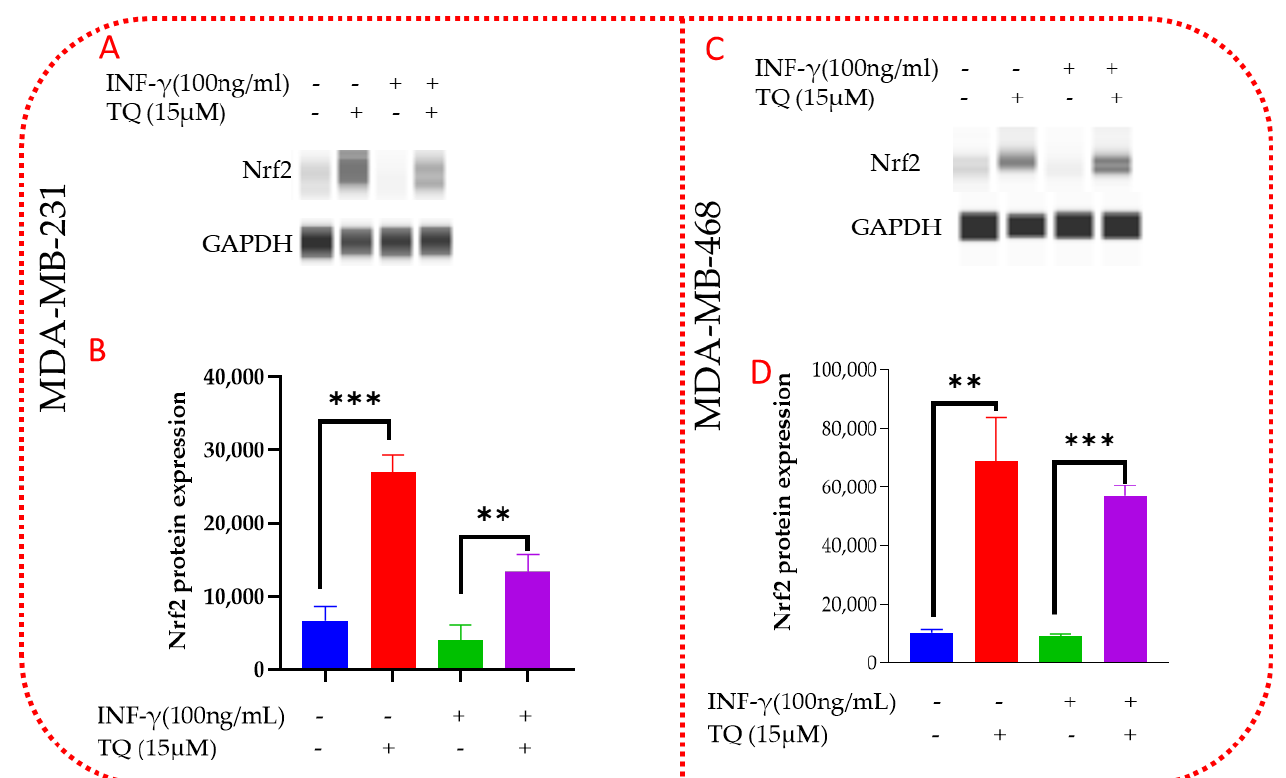
Figure 11. TQ modulatory effect on Nrf2 protein expression in MDA-MB-231 and MDA-MB-468 TNBC cells. Following the overnight incubation period, cells were equally treated with 15 µM of TQ for 24 h, whereas control cells were exposed only to 0.1% DMSO after overnight incubation. The Western analysis used data to evaluate the protein expression of Nrf2 in MDA-MB-231 ( A , B ) and MDA-MB-468 ( C , D ). Figures ( A , C ) present the cropped blots from Compass software corresponding to the protein expression of four samples treated with DMSO, TQ, INF- γ , and TQ + INF- γ .